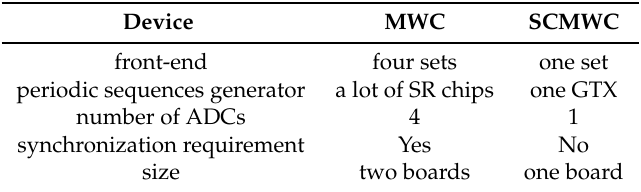
Table 3. Complexity Comparisons between MWC and